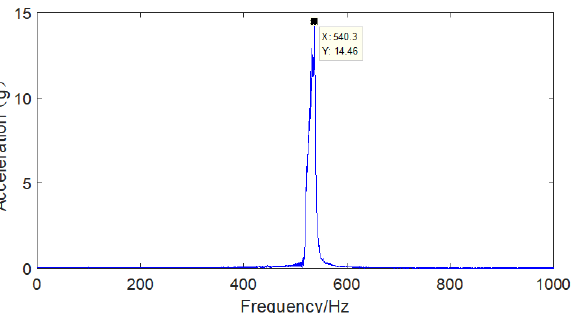
Figure 25. Frequency sweep vibration response of a 304 stainless steel clamp with a 200- μ m-thick hard coating of Z r O 2 -PTFE and 200 μ m.